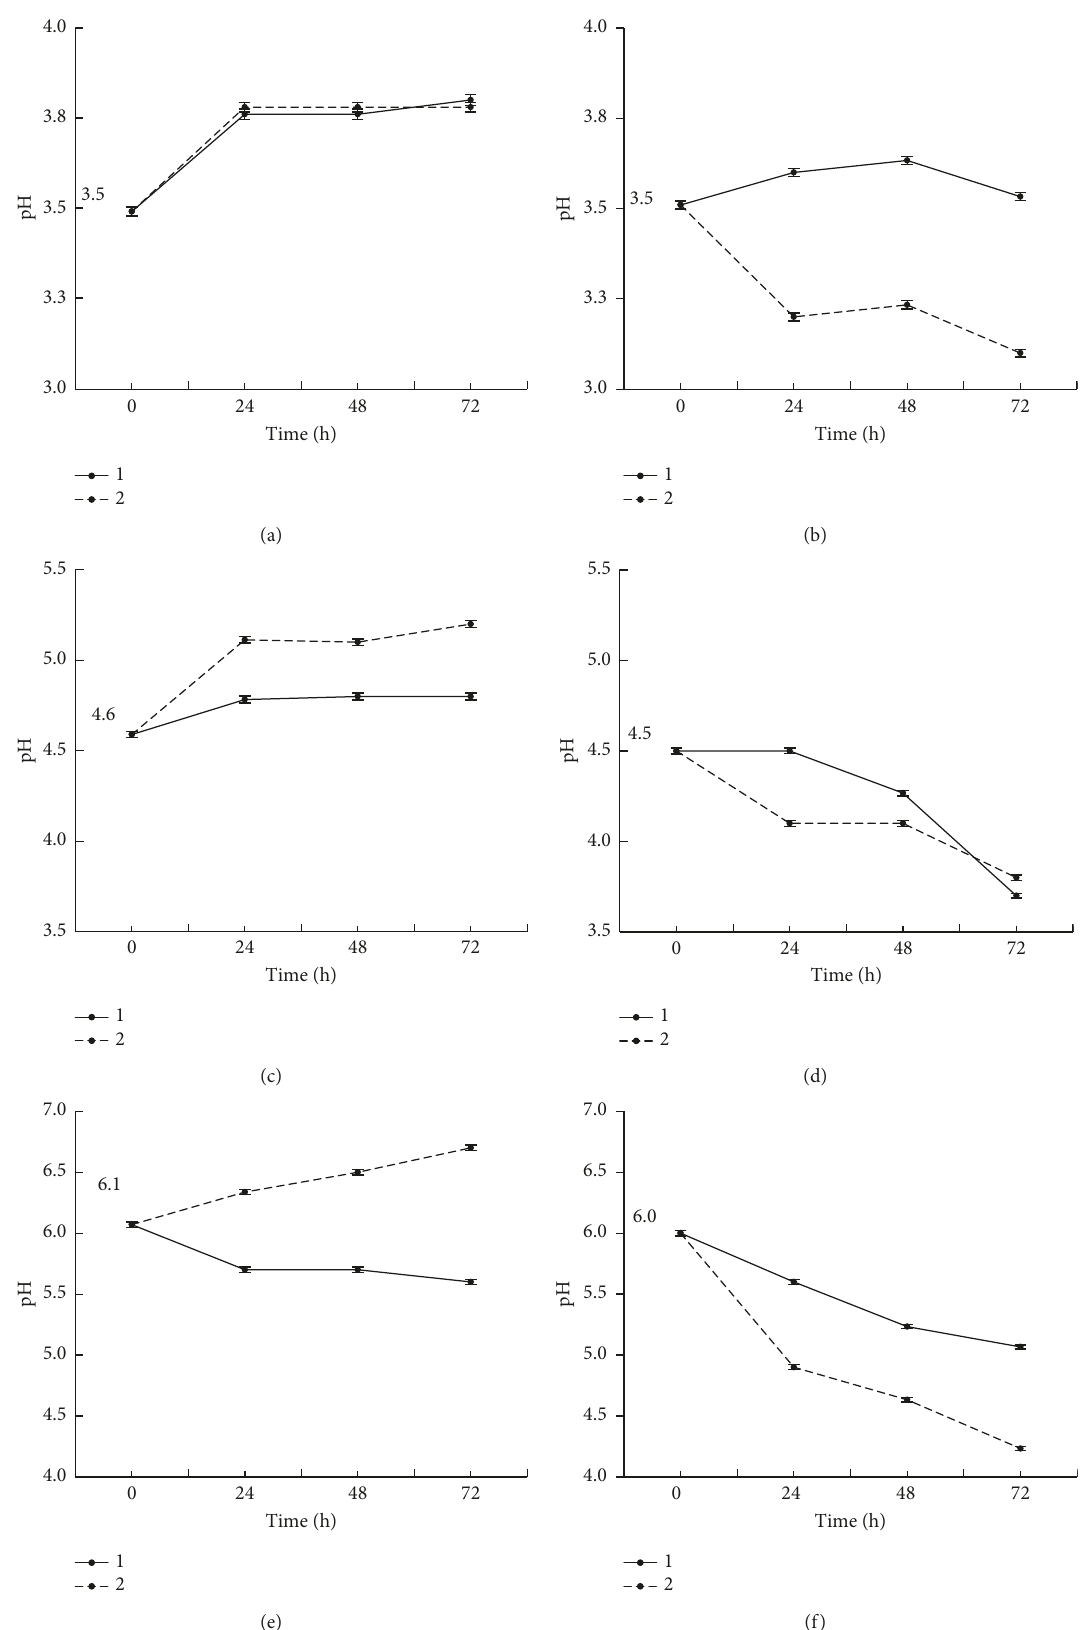
Figure 3: pH trend of Colonies 1 and 2 in absence and presence of sucrose (5%). Conditions: 5 6.0, and 1:10 Water Kefir/metal solution ratio. Left: absence of sucrose. Right: presence of sucrose. n